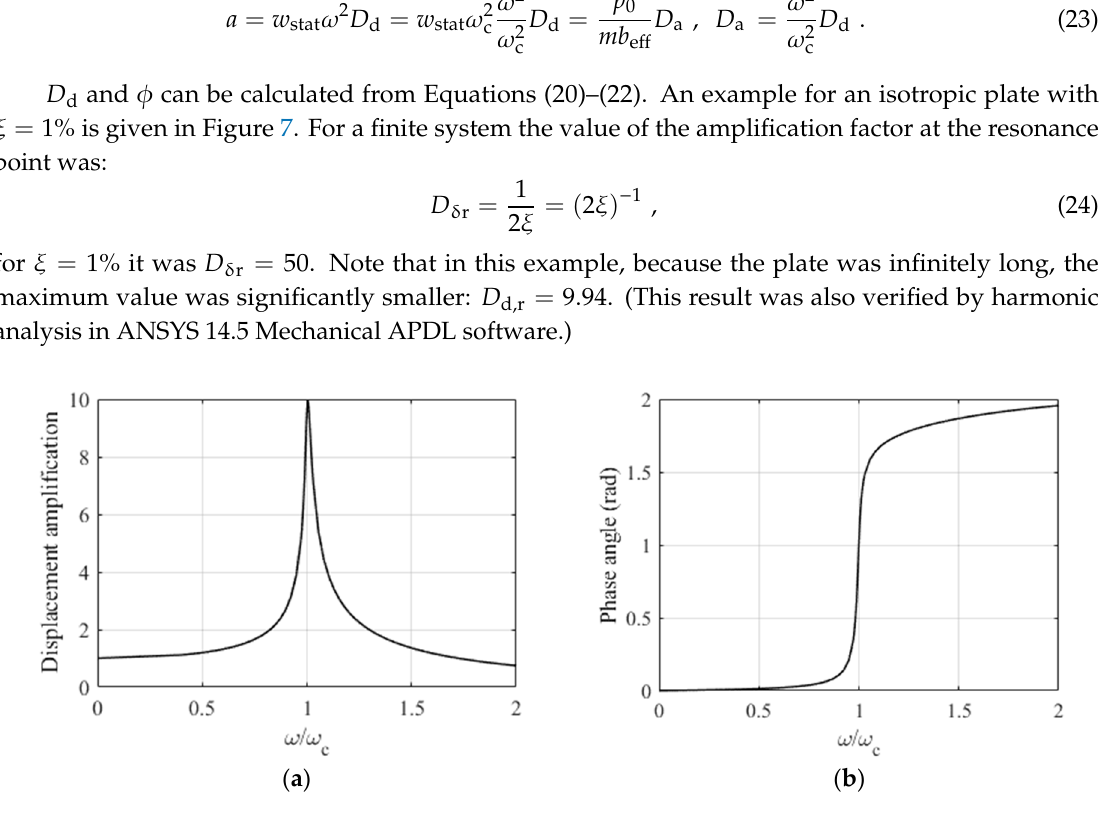
Figure 7. Displacement amplification factor ( a ) and phase angle ( b ) of an infinitely long isotropic plate subjected to a trigonometrical line